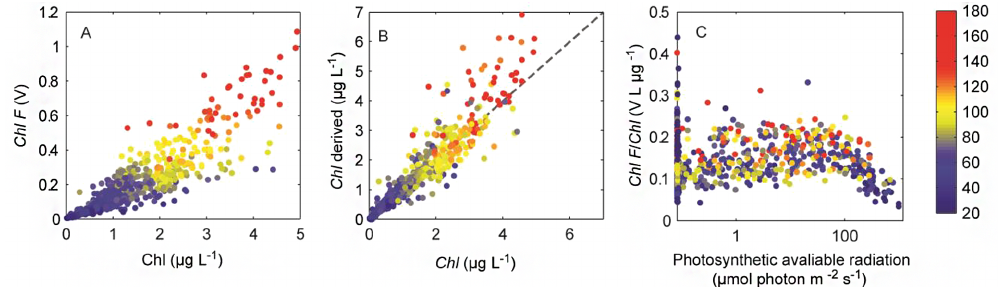
Figure 2. Chlorophyll data from R/V Knorr CTD profiles in May, color-coded by the optical community index, Chl F/b bp (color bar on right; units are V/m). (a) Chl F vs. extracted chlorophyll concentration, Chl, was used to develop a nonlinear best-fit function of temperature, PAR, depth and YD for converting float Chl F to Chl (D’Asaro, 2011). (b) Best-fit-derived Chl vs. extracted Chl shows deviation at higher concentrations (1 : 1 gray dashed line). (c) Chl F normalized to Chl exhibits photoquenching at high PAR (surface